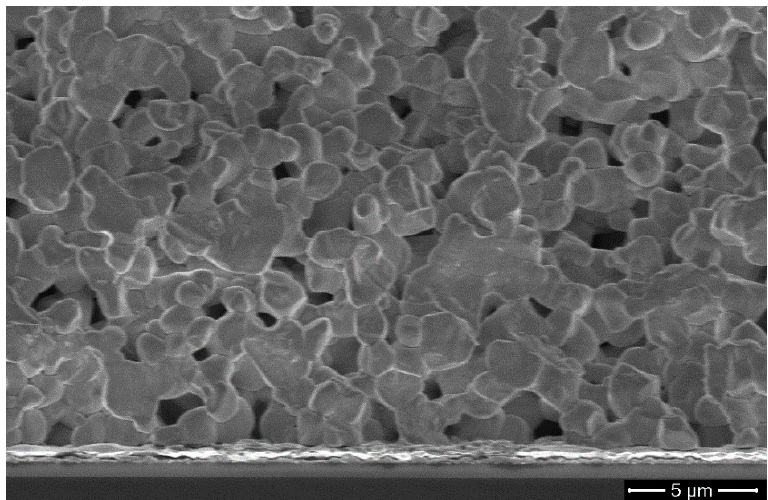
Figure 1. SEM image of typical microstructure of the piezoceramic thick film, clearly showing the high porosity [16]. © 2015 IEEE. Reprinted, with permission, from doi:10.1109/ULTSYM.2015.0277.